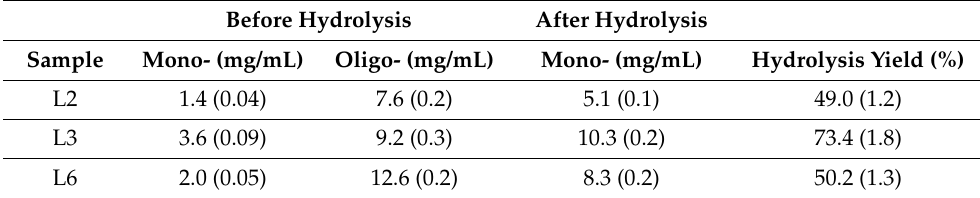
Figure 3. Sugar profile of monosaccharide fraction before and after enzymatic hydrolysis of liquid fraction. Standard error is ≤ 2.5% in all measurements. Table 3. Hydrolysis yield in terms of monosaccharide increase. The fraction of oligosaccharides refers to the sugar streams only (the presence of acetic or uronic acids was not considered). Standard errors are given in parenthesis.